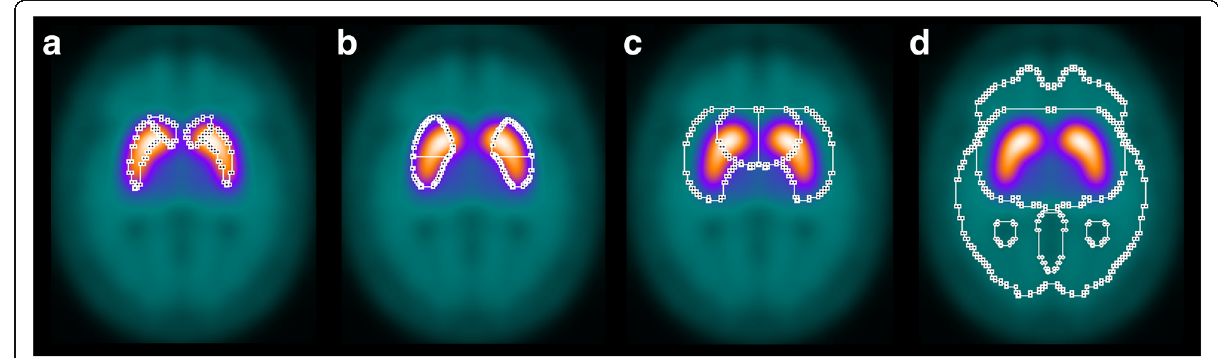
Fig. 1 Anatomical caudate and putamen ROIs from the AAL atlas ( a ), custom-made anatomical ROIs of anterior and posterior putamen ( b ), large ROIs of caudate and putamen ( c ), and reference region ( d ). All ROIs are three-dimensional. The ROIs are overlaid to the custom-made FP-CIT template used as target for stereotactical normalization. The anatomical ROIs in ( a ) and ( b ) were used for computation of the SBR. The large ROIs in ( c ) were used for computation of the SUSI. The custom-made FP-CIT template was obtained by averaging the stereotactically normalized images of 94 visually normal FP-CIT SPECT